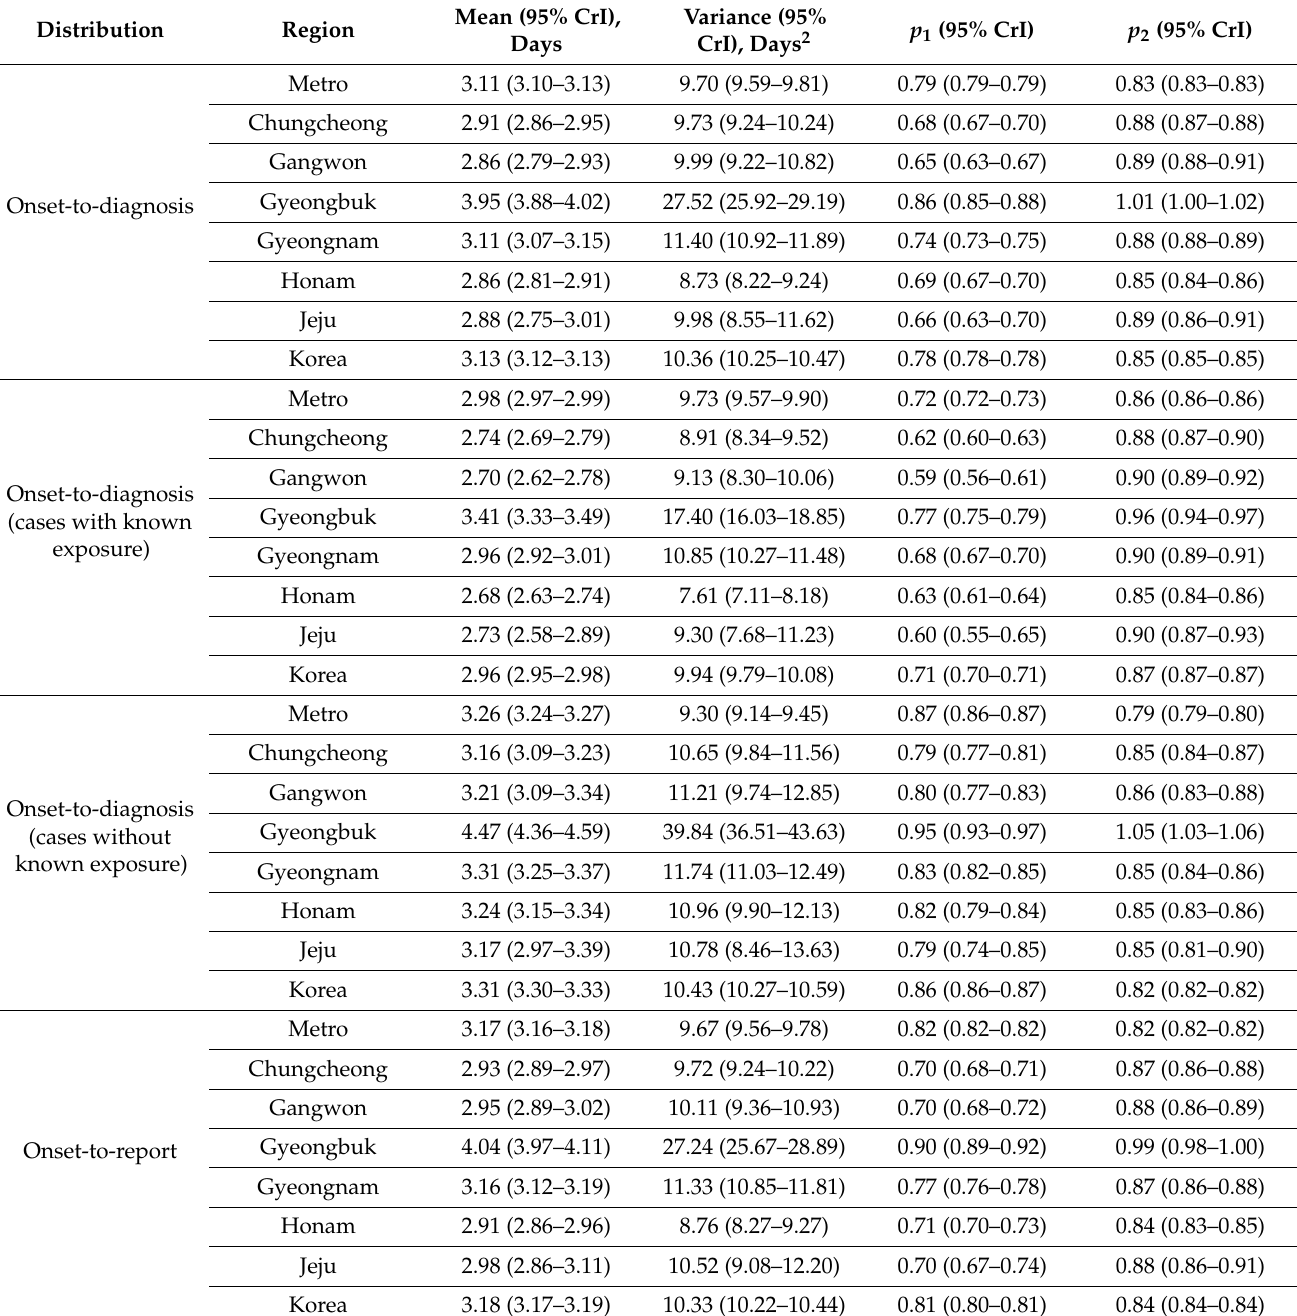
Table 4. Regional-level estimates for the best-fit